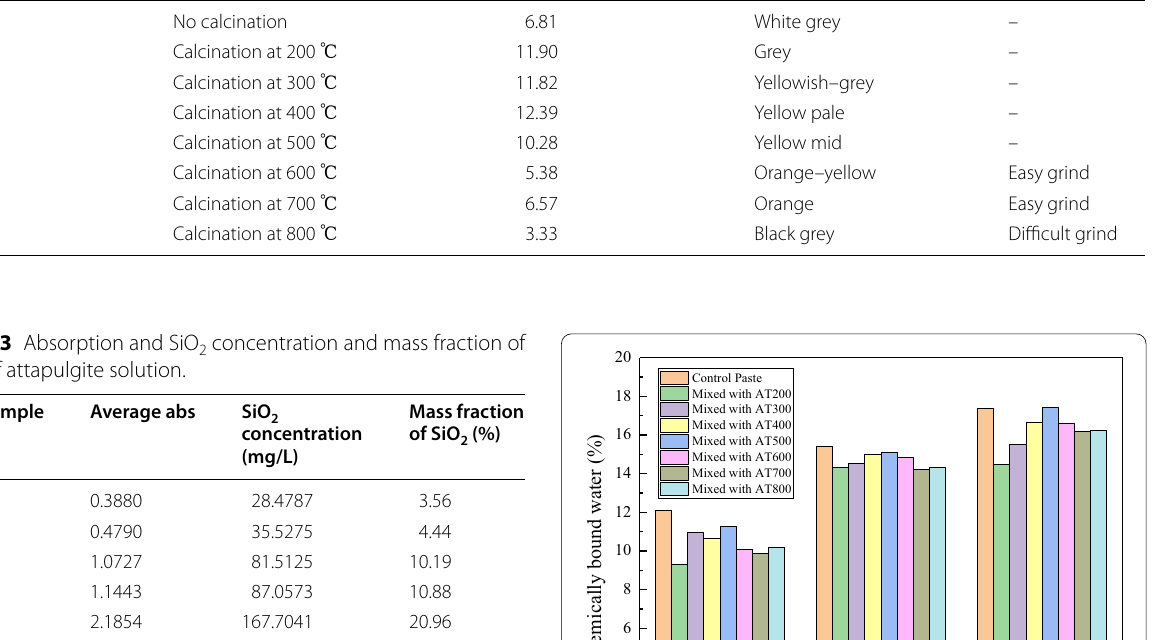
Table 2 Average particle size color and grind condition of attapulgite at different calcination temperatures. Attapulgite sample